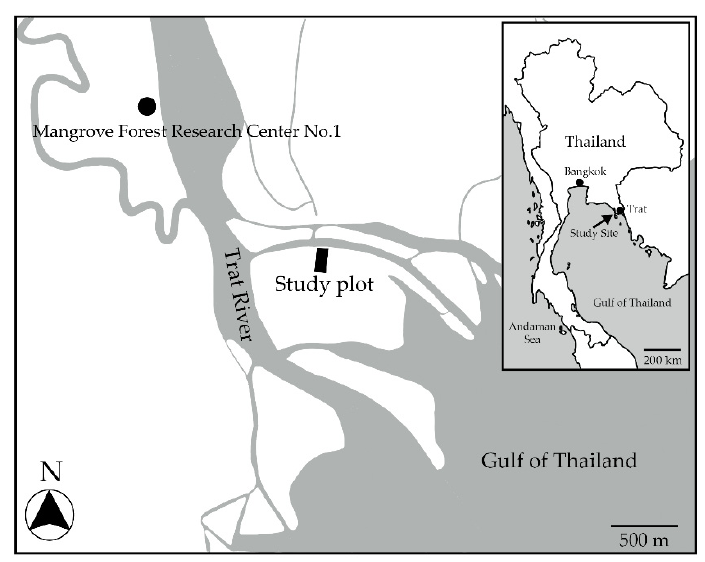
Figure 1. Map of the study site with a mark indicating the location of the permanent study plot.